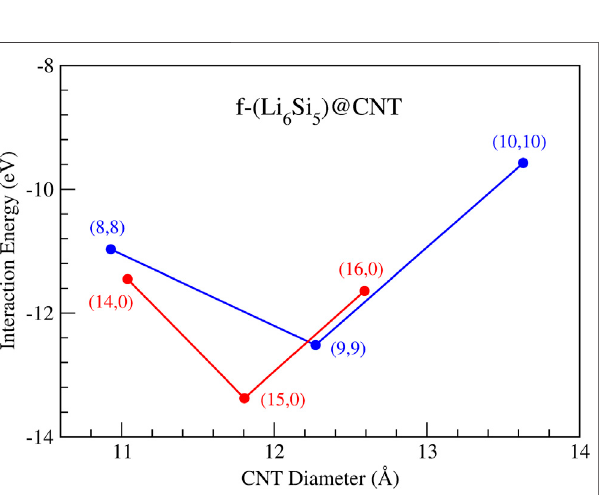
FIGURE 6 | Interaction energy as a function of the nanotube diameters for the fi nite Li 6 Si 5 structures inside armchair CNTs with chiral indexes (8,8), (9,9), and (10,10) and zigzag CNTs with chiral indexes (14,0), (15,0), and (16,0).